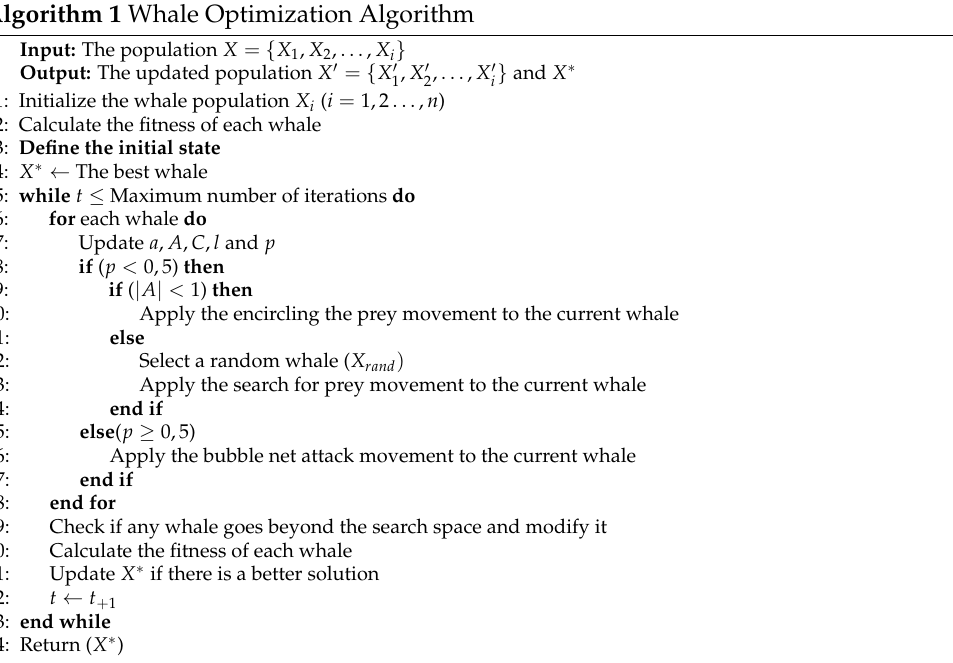
Algorithm 1 Whale Optimization